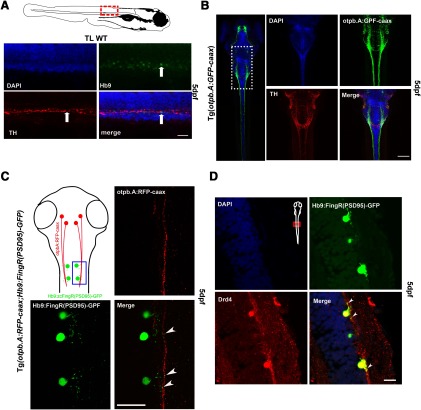
 Dopaminergic synapses to spinal cord motor neurons. A, Confocal images, lateral views of zebrafish spinal cord at 5 dpf, dorsal to top; scale bar: 10 µm. DAPI staining of cell nuclei; anti-Hb9 immunohistochemistry in motor neurons; anti-TH immunohistochemistry of DDT; and double-labeling anti-Hb9 anti-TH shows co-localization (arrows). B, Confocal images, dorsal views of zebrafish at 5 dpf, rostral top. Left panel shows entire larva with DDT labeled by GFP in Tg(otpb.A:EGFP-caax) line. Higher magnification (scale bar: 50 µm) shows DAPI staining of cell nuclei; GFP labeling of DDT; anti-TH labeling of TH; and co-localization of TH and GFP in DDT. C, Tg(otpb.A:TRFP-caax); Tg(Hb9:FingR(PSD95)-GFP) larvae, confocal images, dorsal views, of spinal cord at 5 dpf (scale bar: 10 µm). FingR localization of PSD95, expressed in motor neurons, of synapses can be seen neighboring DDT labeled by RFP (arrowheads). D, Anti-D4R labeling co-localizes with FingR GFP expression (scale bar: 10 µm).